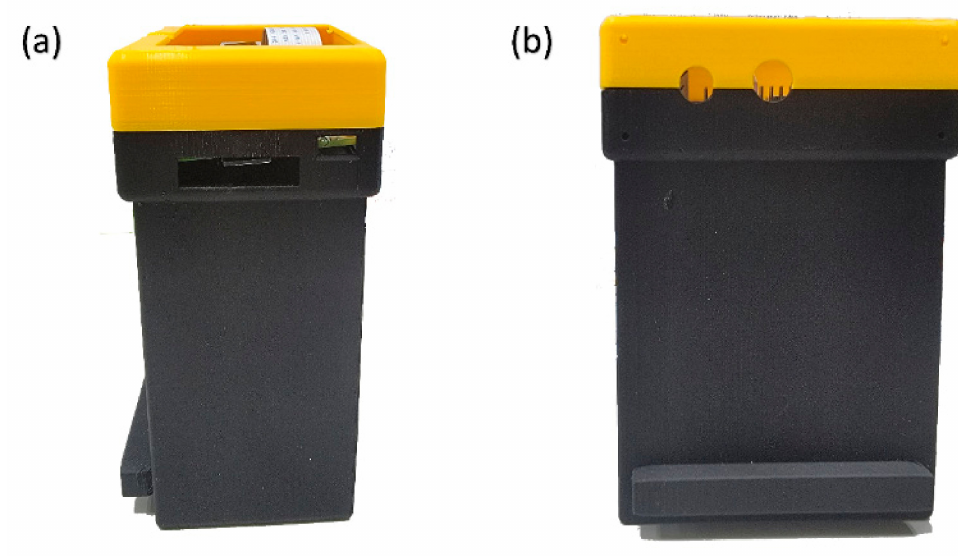
Figure 3. ( a ) Front view and ( b ) side view of the 3D printed